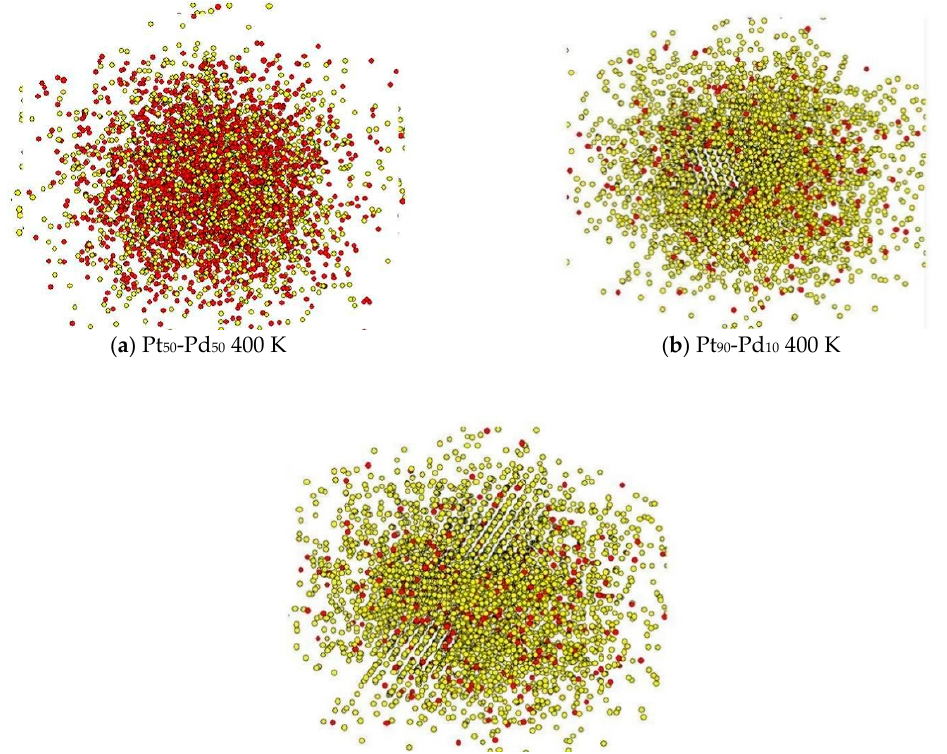
Figure 7. The image of atomic distribution at a defined annealing temperature for alloys (yellow atoms are Pt atoms).